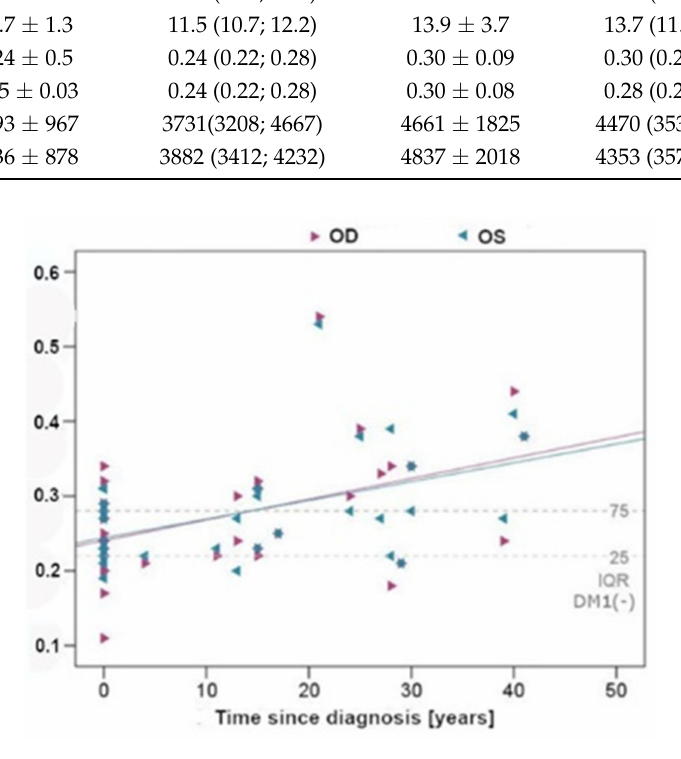
Figure 3. Correlation between WLR and DM1 duration. IQR (interquartile range 25 percentile–75 percentile) for the control group (duration of diabetes is zero) is indicated in the graph, left eye (OS), and right eye (OD), Asterisk same values in different patients. Multivariate analysis showed a positive correlation between WT, WLR, WCSA, and diabetes duration, considering age, gender, and BMI (Table 4). Table 4. Multivariate analysis of correlation of WT, WLR, and WCSA with duration of diabetes in patients with DM1, left eye (l), and right eye